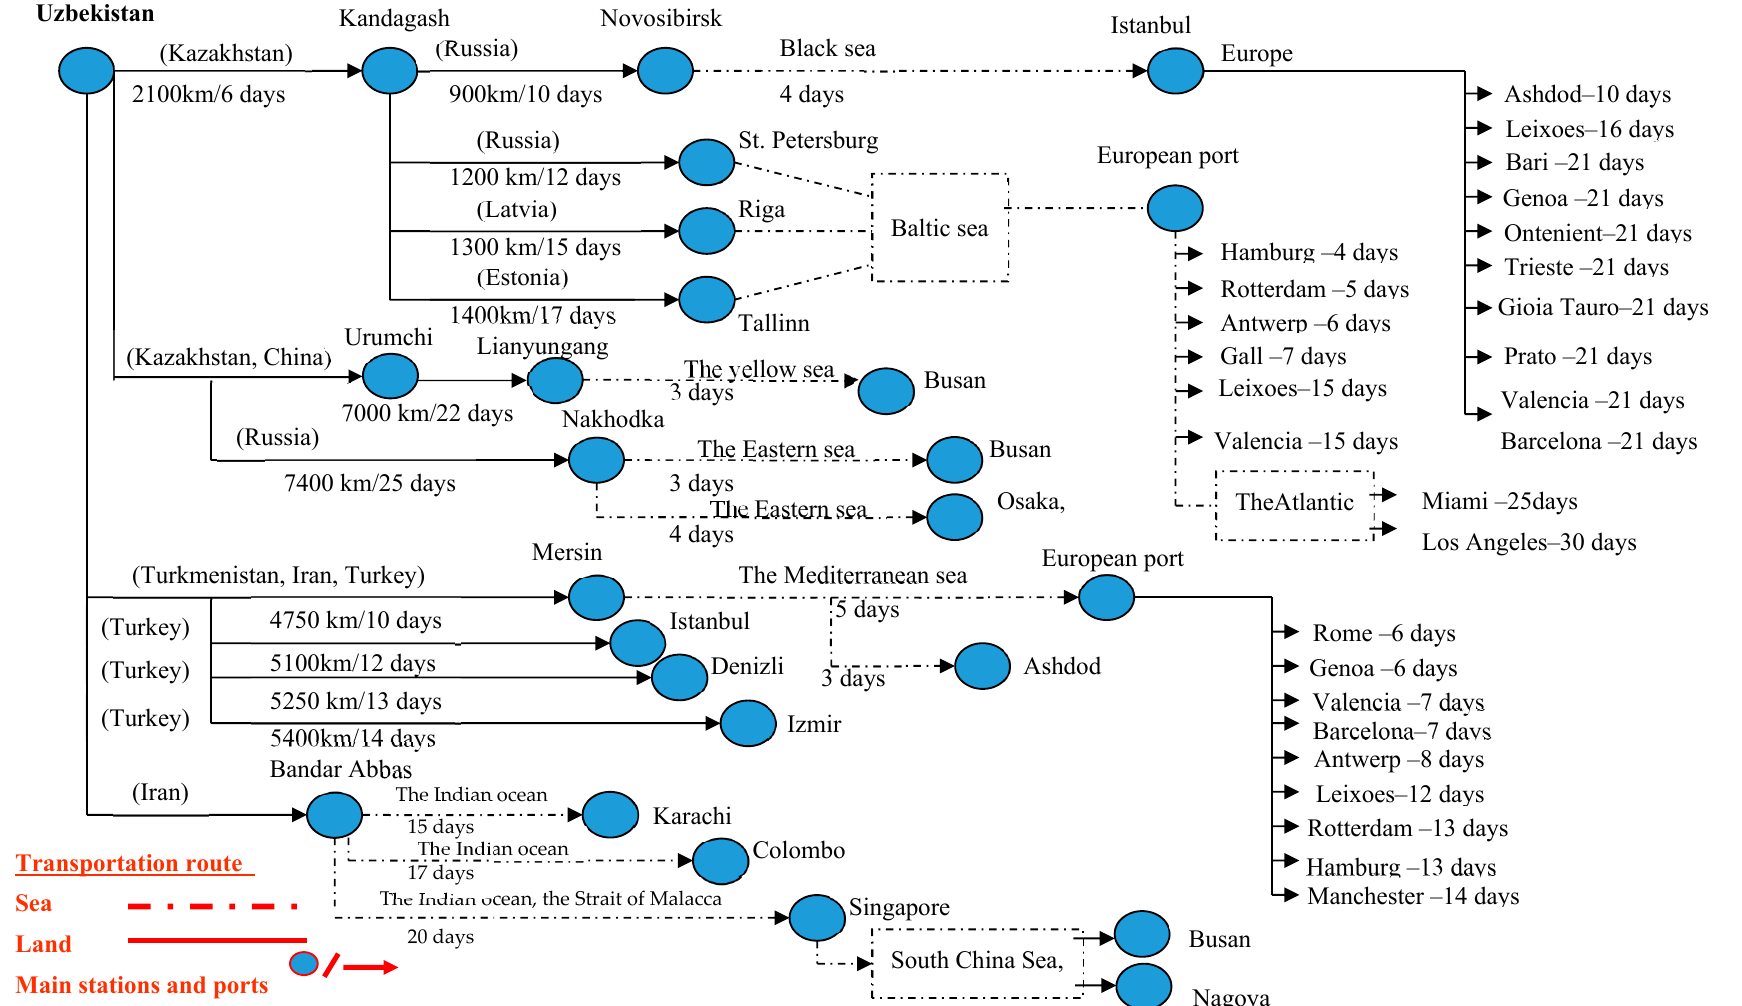
Figure 1. The route of transport corridors of Uzbekistan used for international shipping of textile products.